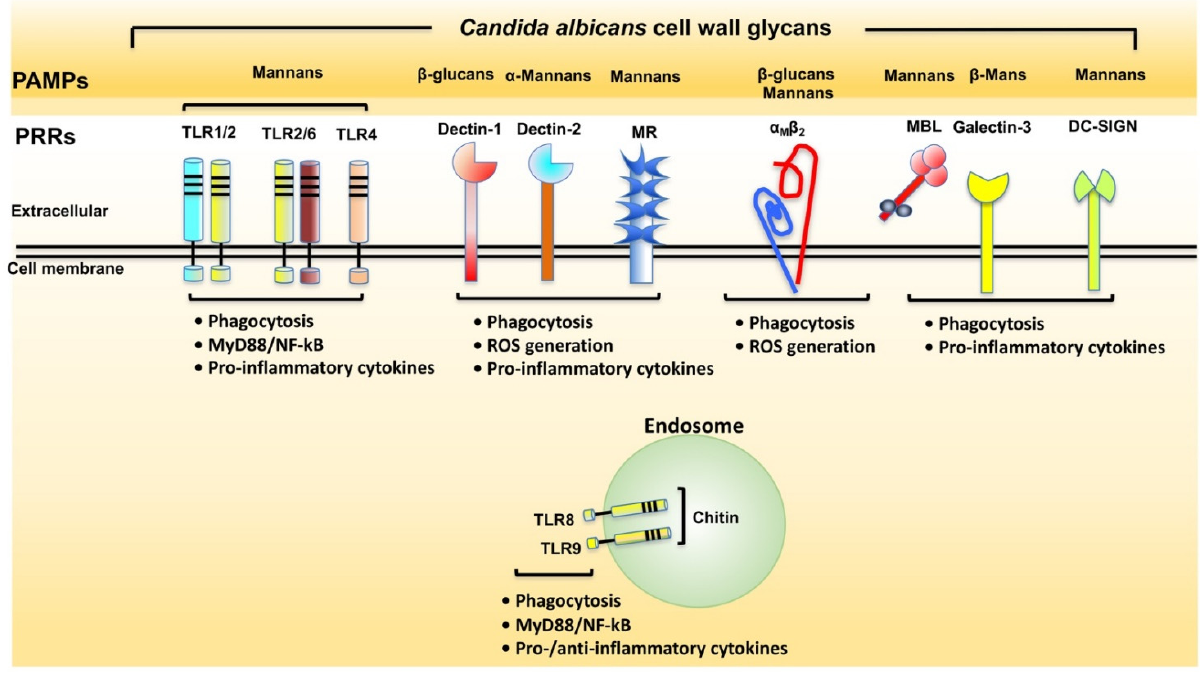
Figure 2. Diagrammatic representation of the main pattern recognition receptors (PRRs) involved in sensing C. albicans cell wall glycans.